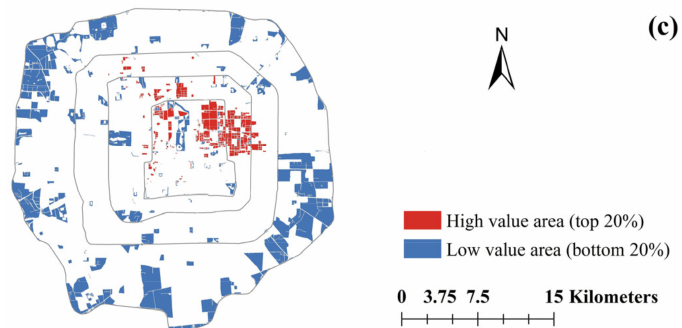
Figure 11. ( a ) Spatial distribution of settlement intention index (SII), ( b ) violin diagram of SII between ring roads, and ( c ) spatial distributions of high and low values of